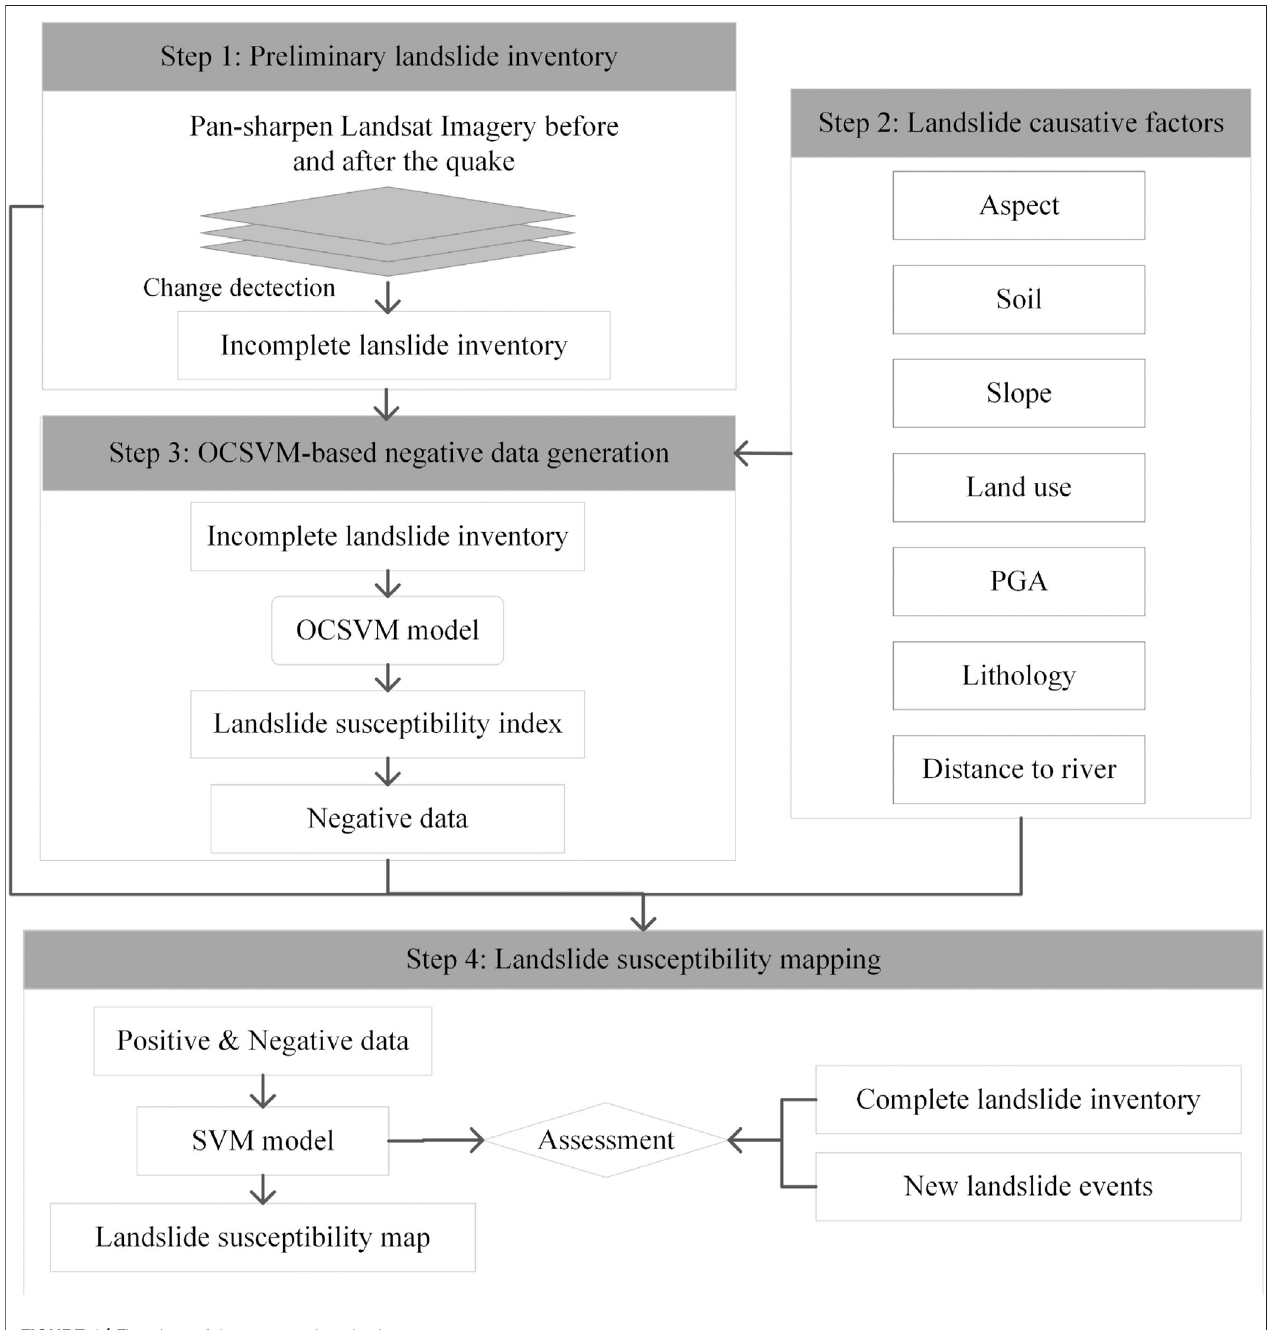
FIGURE 1 | Flowchart of the presented